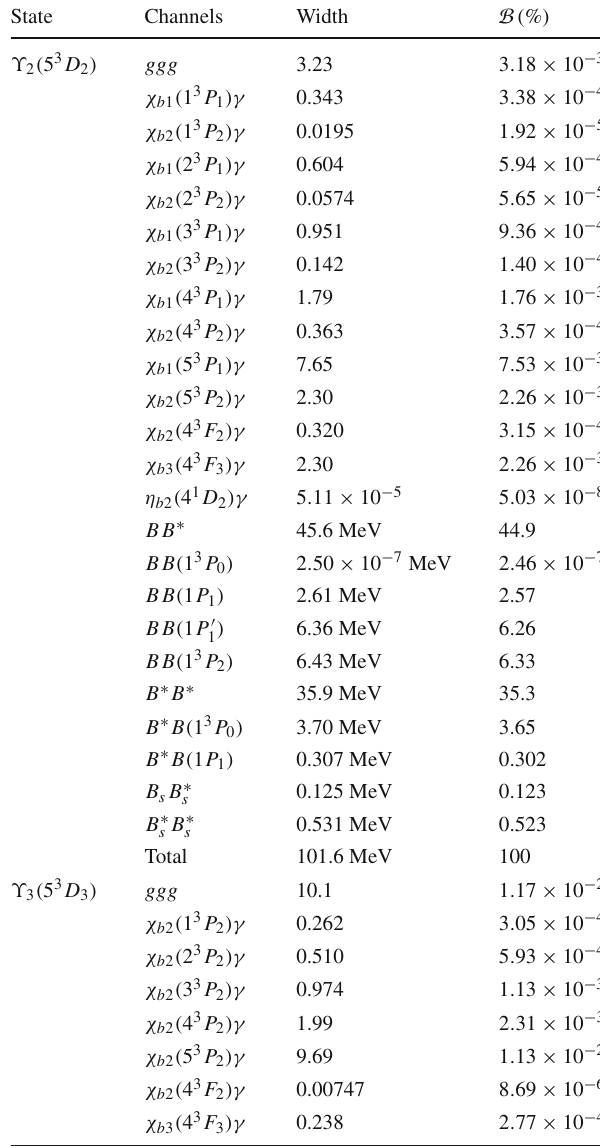
Table32 PartialwidthsandbranchingratiosoftheOZI-allowedstrong decay, annihilation decay, and radiative transition and total widths for 5 3 D 2 and 5 3 D 3 bottomonium states. The width results are in units